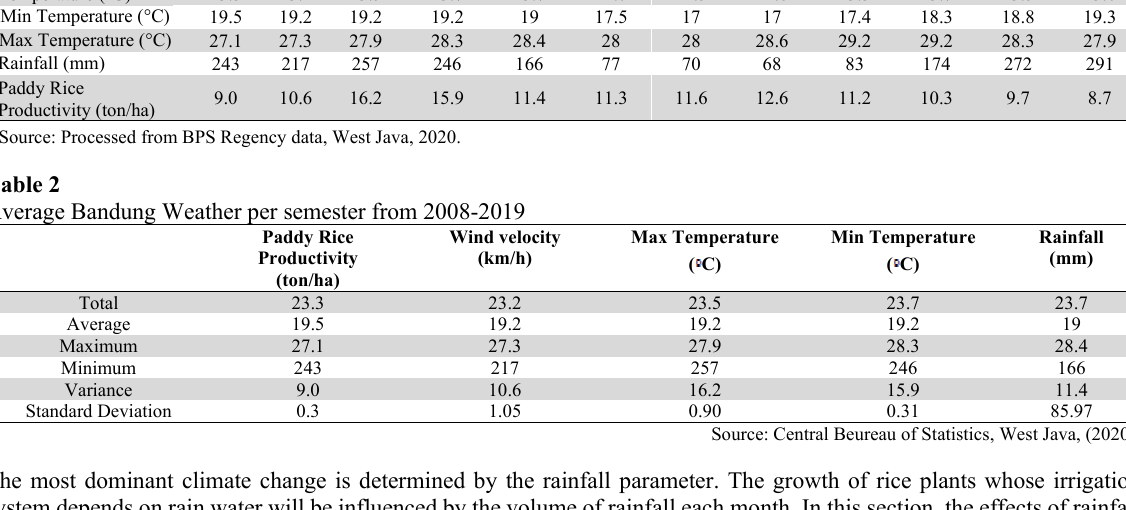
Average Bandung Weather per month from 2008-2019.